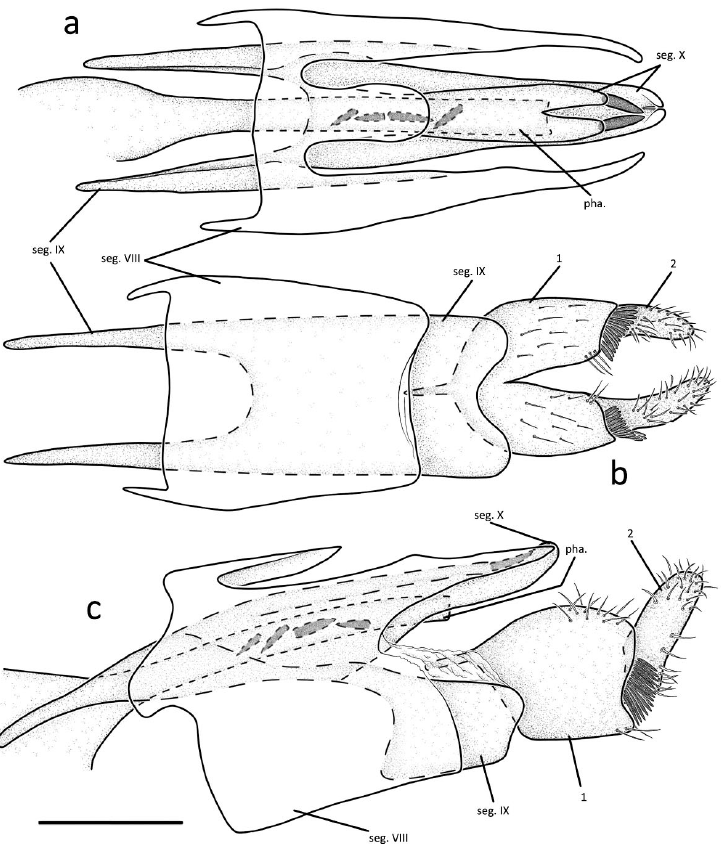
Figure 2. Male genitalia of Gunungiella wangi , Peng, Ge and Sun n. sp.: ( a ) dorsal; ( b ) ventral; ( c ) left lateral. Abbreviations: seg. VIII = segment VIII; seg. IX = segment IX; seg. X = segment X; 1 = first article (paired); 2 = second article (paired); pha. = phallus. Scale bar: 0.2 mm. 3.1.2. Gunungiella flabellata , Peng, Ge and Sun n. sp. (Figures 1b and 3a–e)